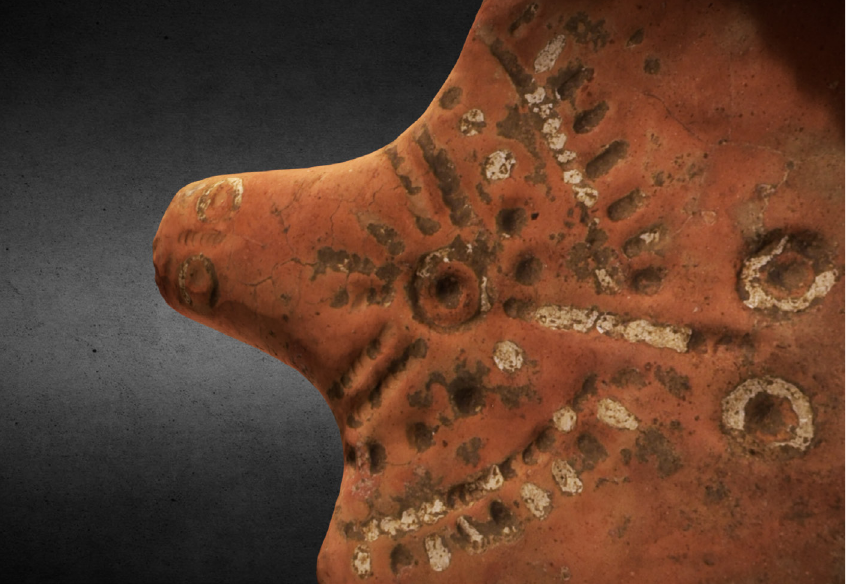
Figure 3. The Bronze Age Vršac Idol, Serbia, with light and shadow manipulated to emphasise stamped and encrusted decora- tion (processed directly on publically accessible Sketchfab website (https://skfb.ly/SzwE)). Model generated courtesy of Vršac town museum and made by J.